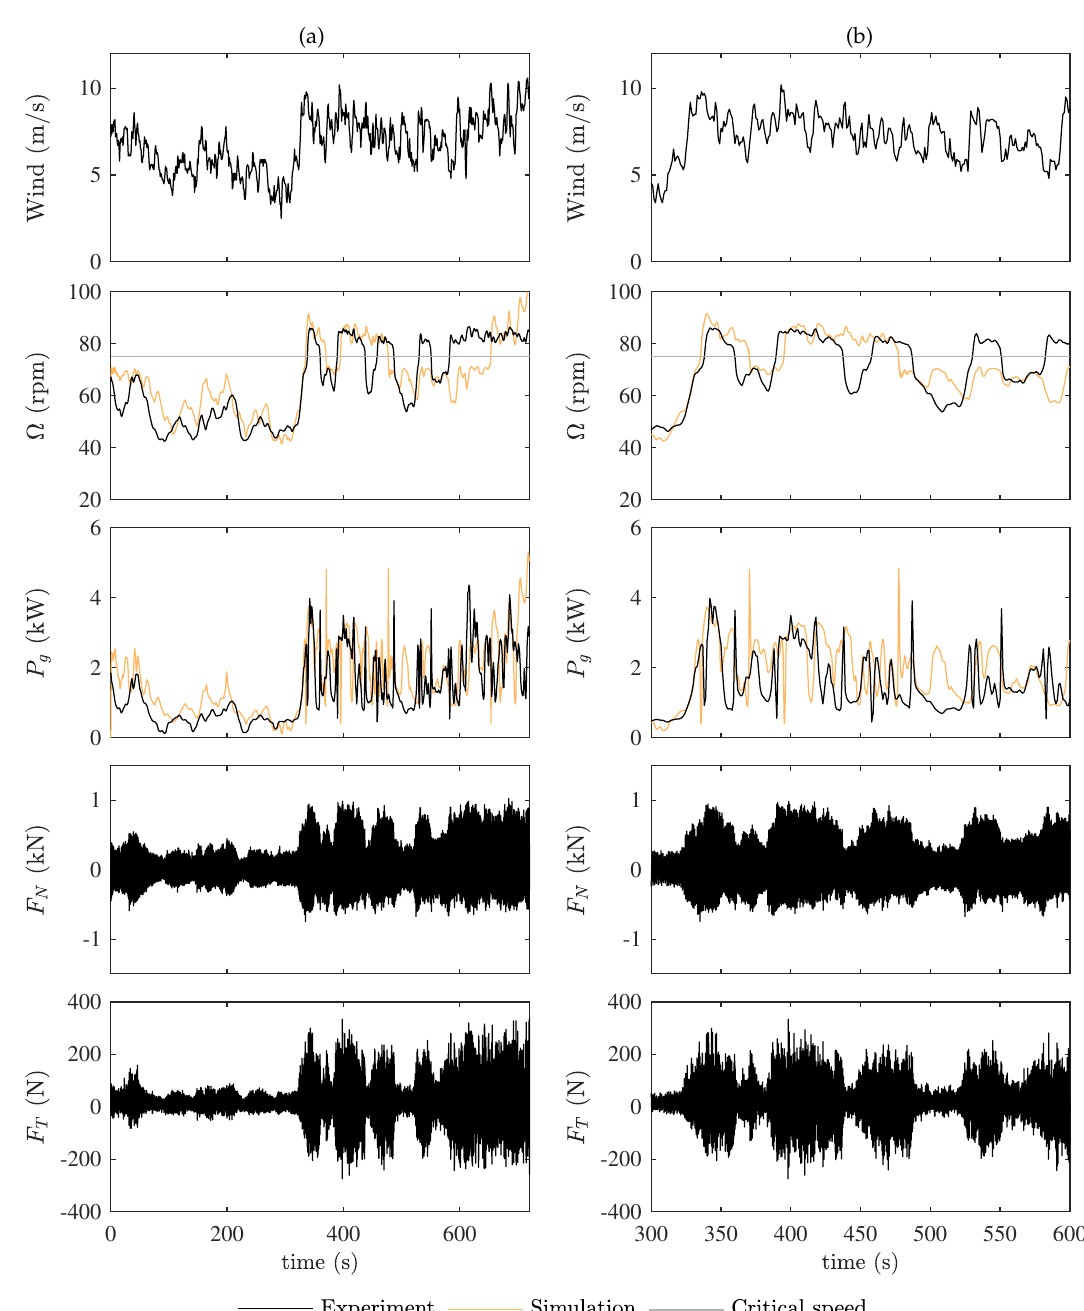
Figure 7. Experimental results and simulation comparison for a critical speed at 75rpm, showing the full 12-min run in ( a ) and a 5-min extraction in ( b